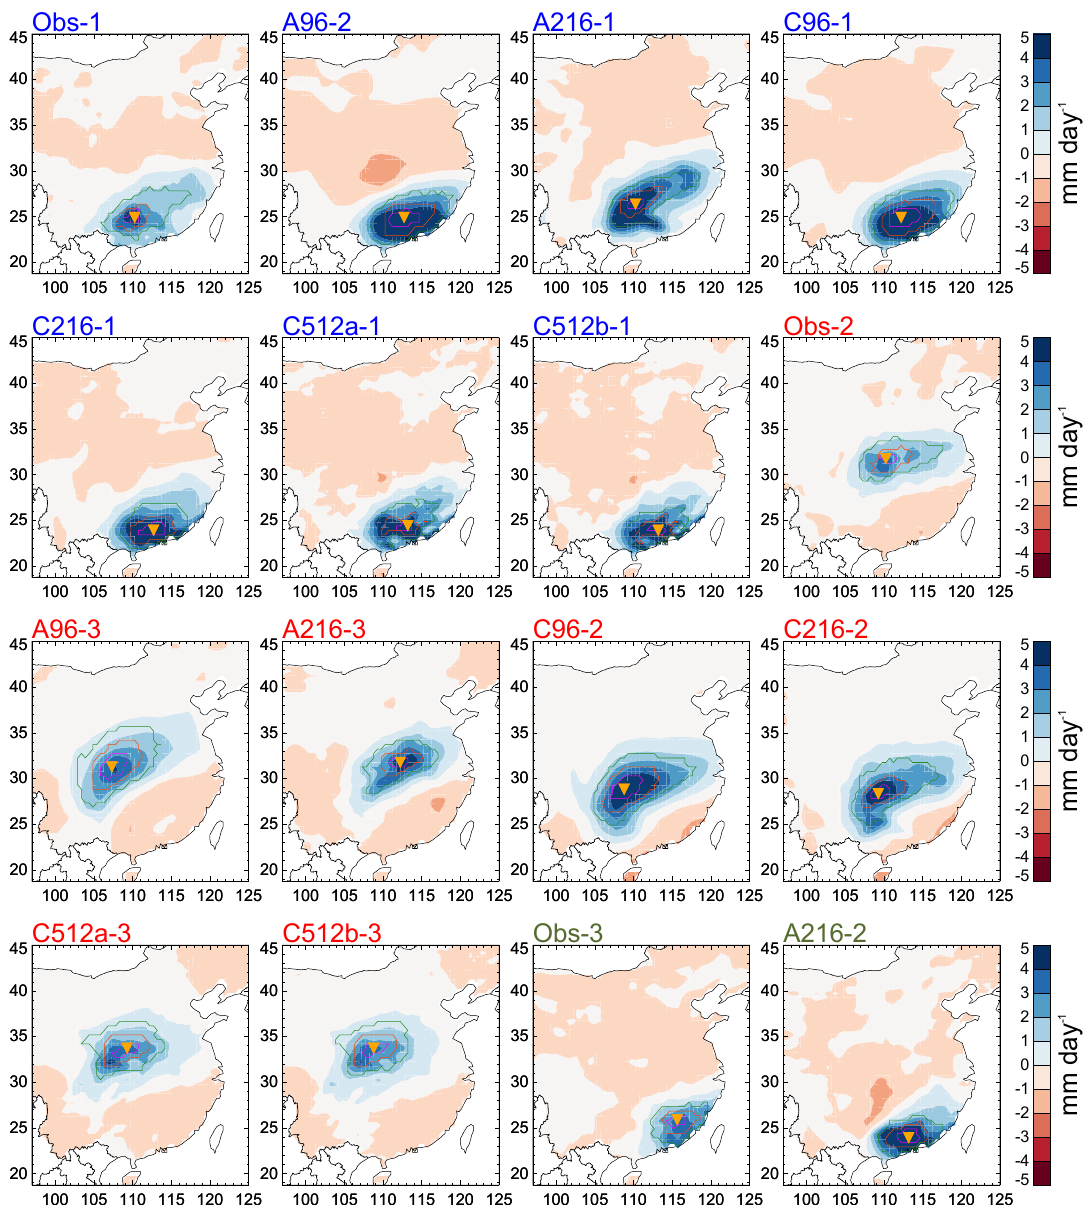
Figure 8. Observed (Obs) and simulated EOT patterns corresponding to Obs-1 (blue labels), Obs-2 (red labels), and Obs-3 (gray labels). Shading shows regressions of MJJASO precipitation against the normalized EOT time series. Contours show correlations of the full (leading order) or residual (higher order) precipitation anomaly time series with the EOT base point exceeding 0.8 (magenta), 0.6 (orange), and 0.4 (green). The EOT base point is marked by the orange inverted